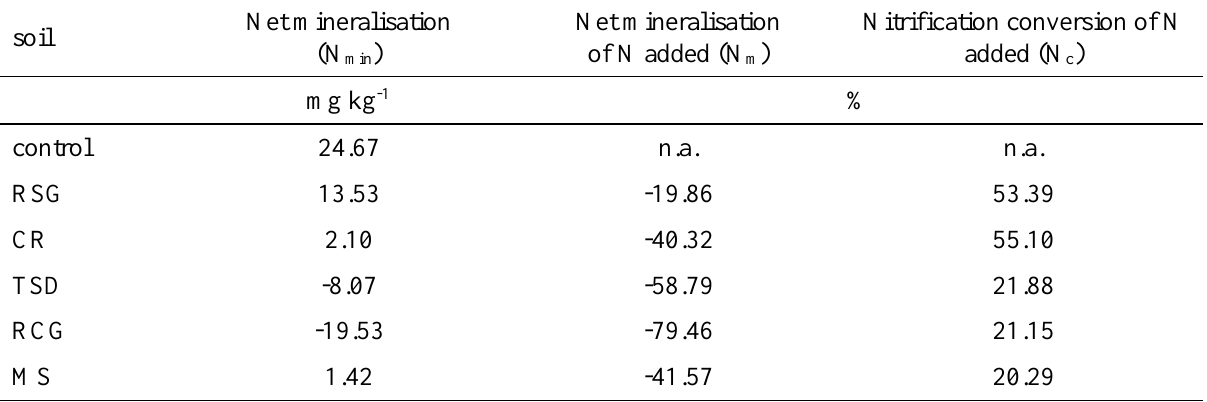
Table 3. Net mineralisation (N min ), net mineralisation of N added (N m ) and nitrification conversion of N added (N c ) in control and soils fertilised with digestates from anaerobic digestion of reed sweet-grass (RSG), common reed (CR), tufted sedge (TSD), reed canary grass (RCG) and maize (MS). n.a. = not